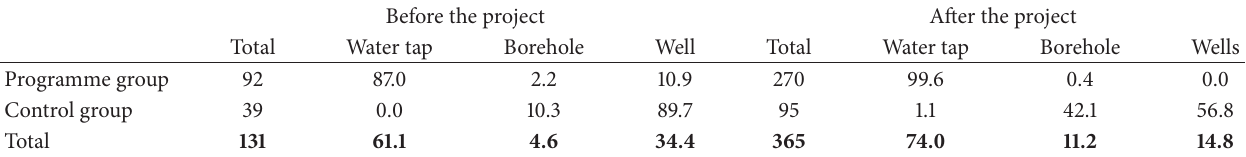
Table 3: Percentage of use of drinking water sources at school before and after the project. Before the project